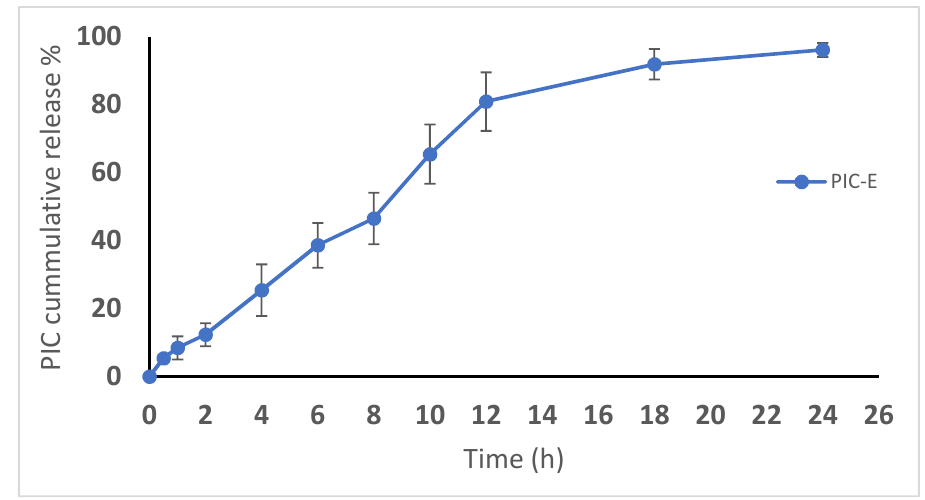
Figure 4. TEM image of PIC-E (X 60,000).